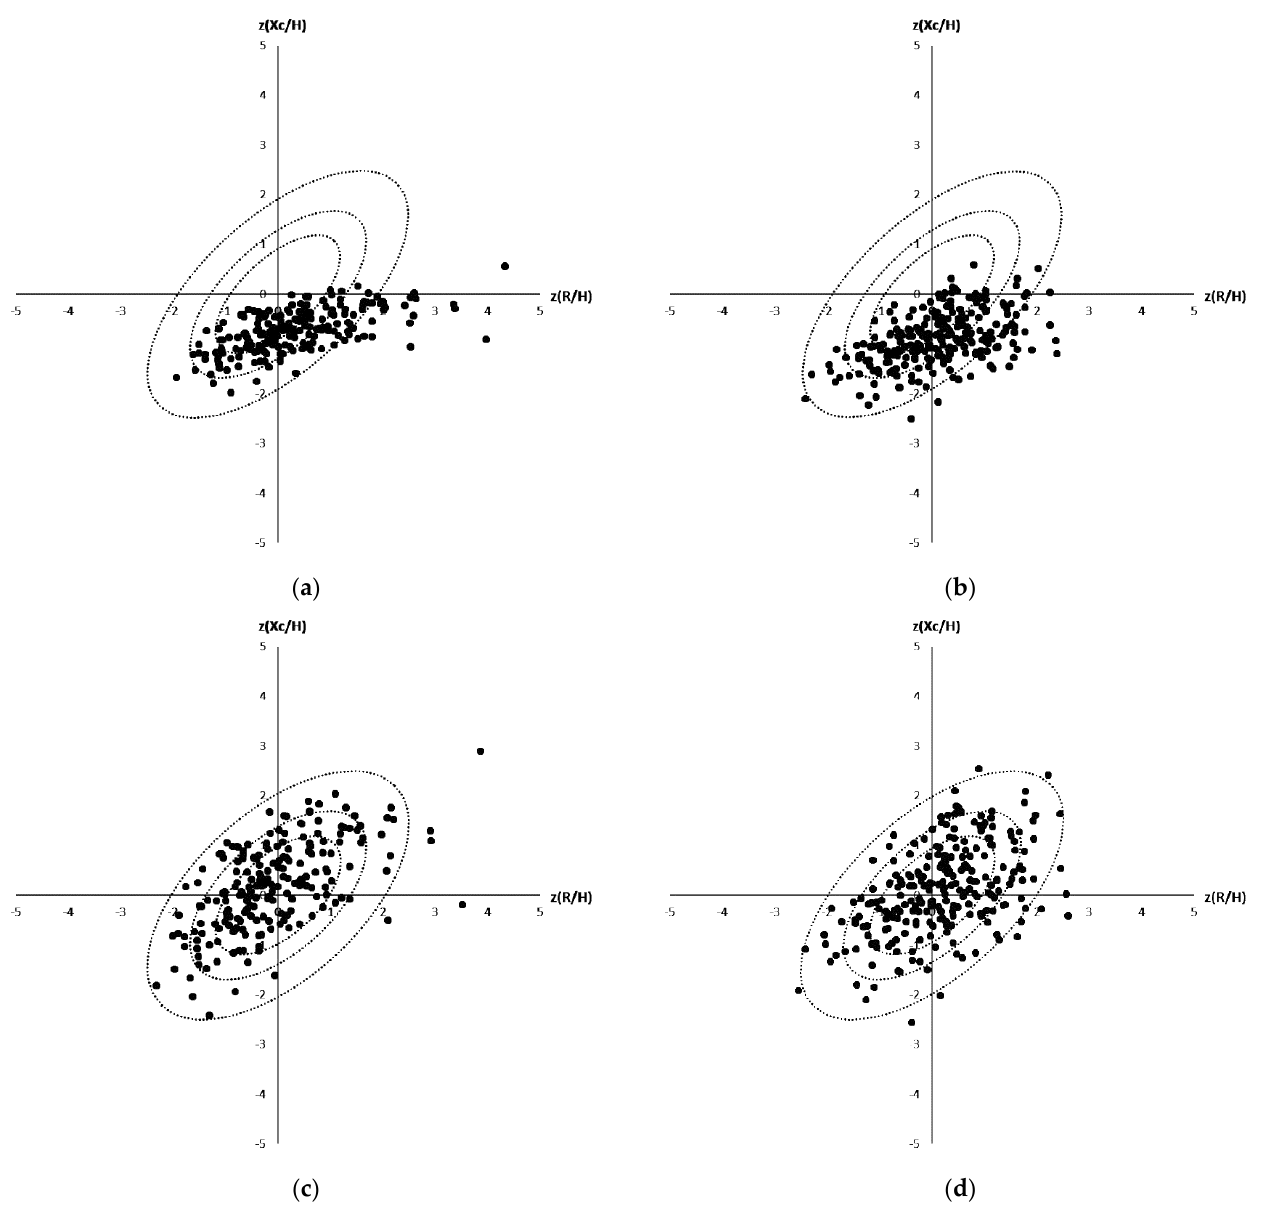
Figure 2. ( a – d ): Distribution of the Coburg patients in a Bioelectrical Impedance Vector Analyses (male ( a , c ), female ( b , d )) plotted against reported tolerance intervals of the reference population reported by Roubenoff et al. ( a + b ) and against tolerance ellipses calculated based on all 447 patients being included in the Coburg ’ s cohort ( c + d ).